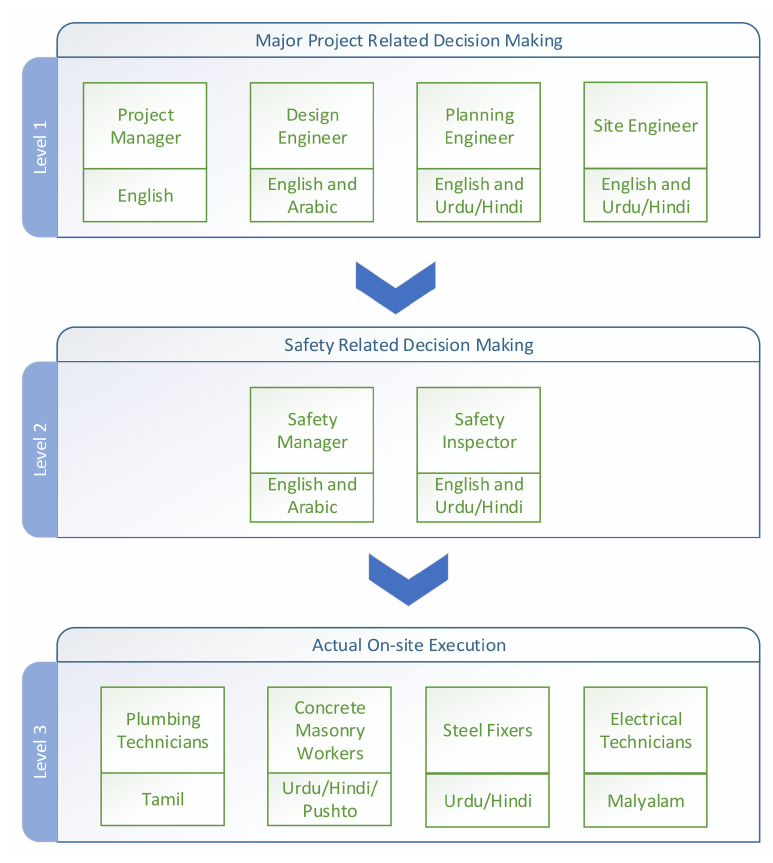
Figure 2. Language and hierarchical level representation of construction